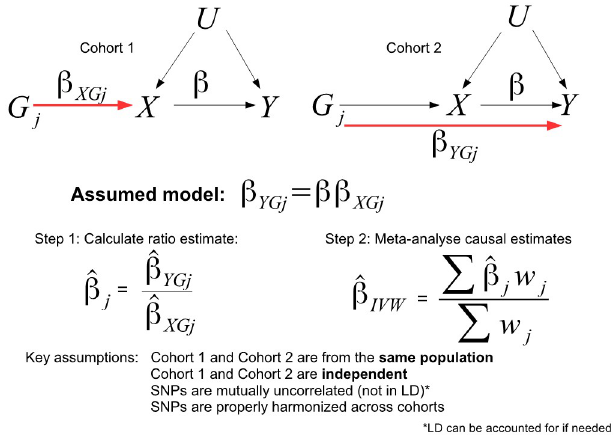
Fig 2. In two sample summary data MR, ( G − X ) association estimates, ^ b ( G − Y ) association estimates, ^ b from a separate, non-overlapping cohort, to produce a set of SNP-specific YGj causal estimates, ^ b . These are combined using inverse variance weighted meta-analysis ( w j being the weight) to j obtain an overall estimate ^ b for the true causal effect β IVW